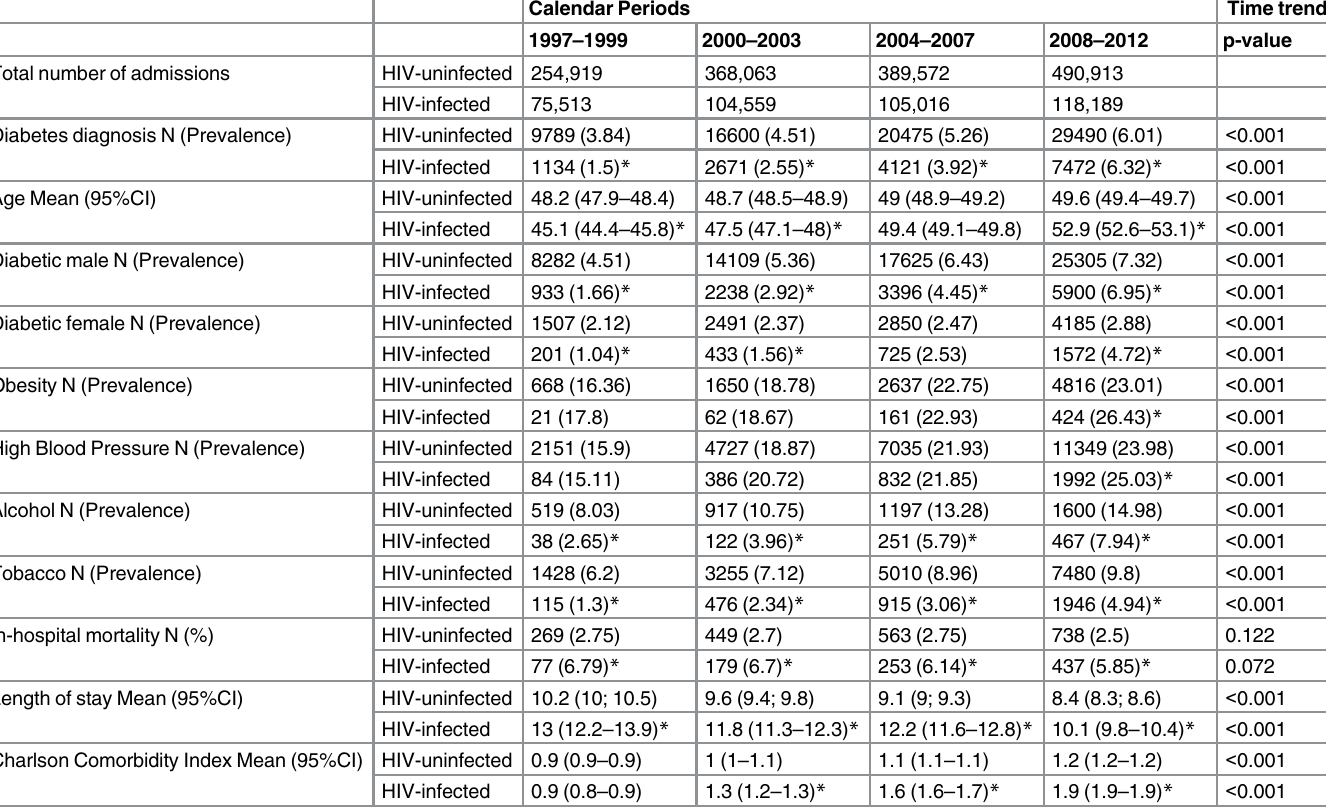
* Chi-square or Fisher exact test were used to compare categorical data and proportions and t test or Mann-Whitney test to compare continuous variables between HIV-uninfected and infected patients within each time period and in the total period. Time trend p-values for the prevalence of diabetes were estimated using a Poisson regression